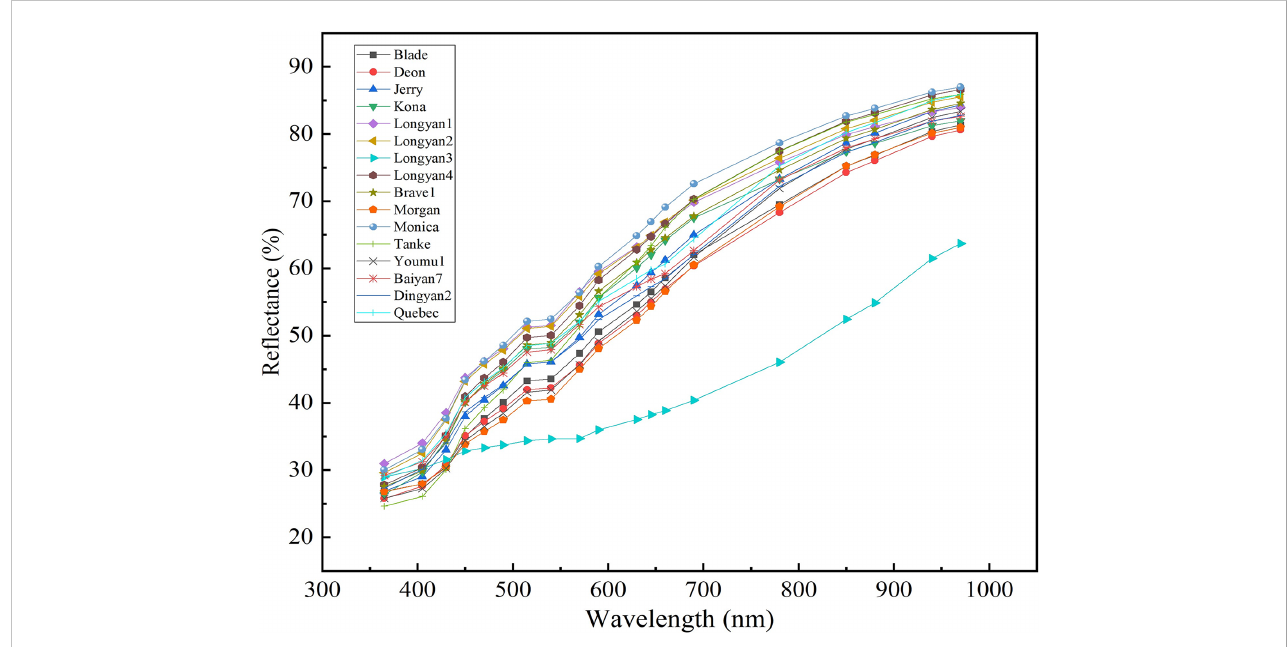
The spectral re fl ectance curves of oat seeds of different cultivars were smooth and had the similar trend across the whole wavelength